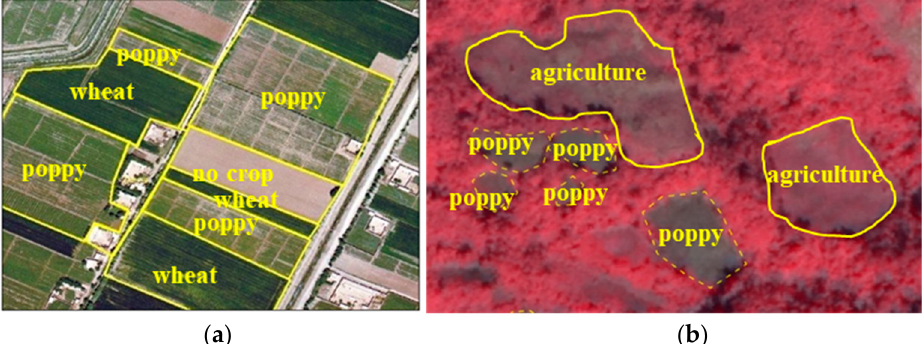
Figure 1. Differences in opium poppy fields between ( a ) Afghanistan and ( b ) Lao PDR.